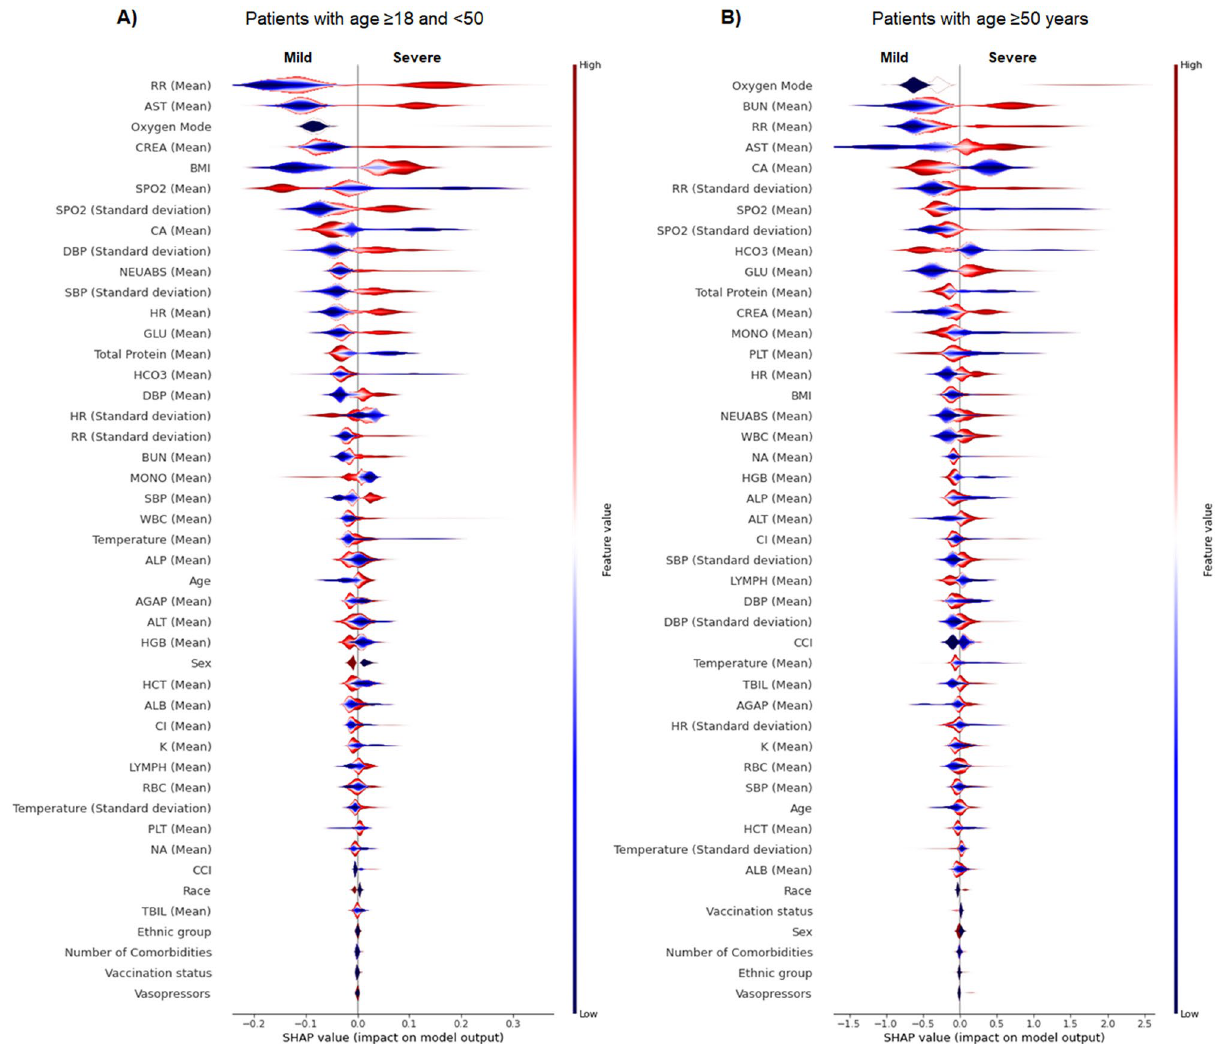
Figure 2. Gradient Boosting Decision Tree feature importance for age-stratified models of severe COVID-19 outcomes in hospitalized patients. ( A ) Feature importance and the influence of higher and lower values of the risk factors on the patient with age ≥ 18 and < 50 years outcome, ( B ) Feature importance and the influence of higher and lower values of the risk factors on the patient with age ≥ 50 years outcome. Note that the left side of this graph represents reduced risk of critical illness or death, and the right side of the graph represents the increased risk of critical illness and death outcome. Nominal classes are binary [0, 1]. For sex, female is 0 (blue) and for race, White is 0